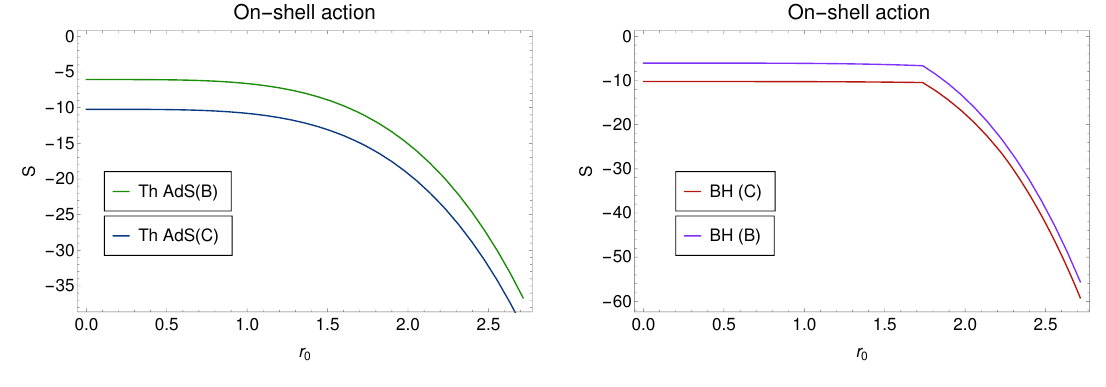
Figure 6 . Energies of various branes: b = 0 . 5 , m q = 1 . 7 .